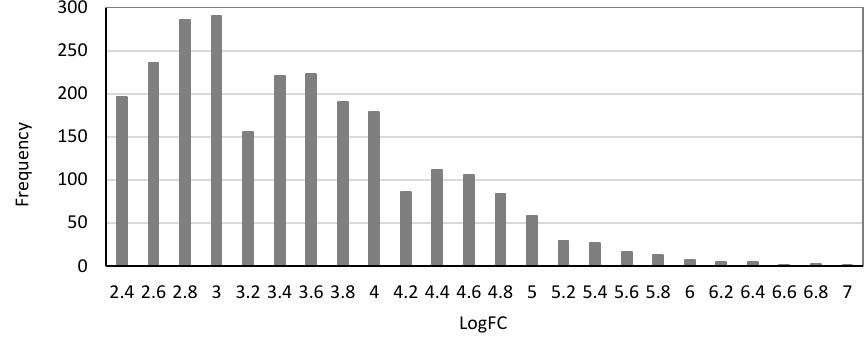
Figure 3. Histogram of cleaned Log FC data. The bin value indicates upper limit of that bin.